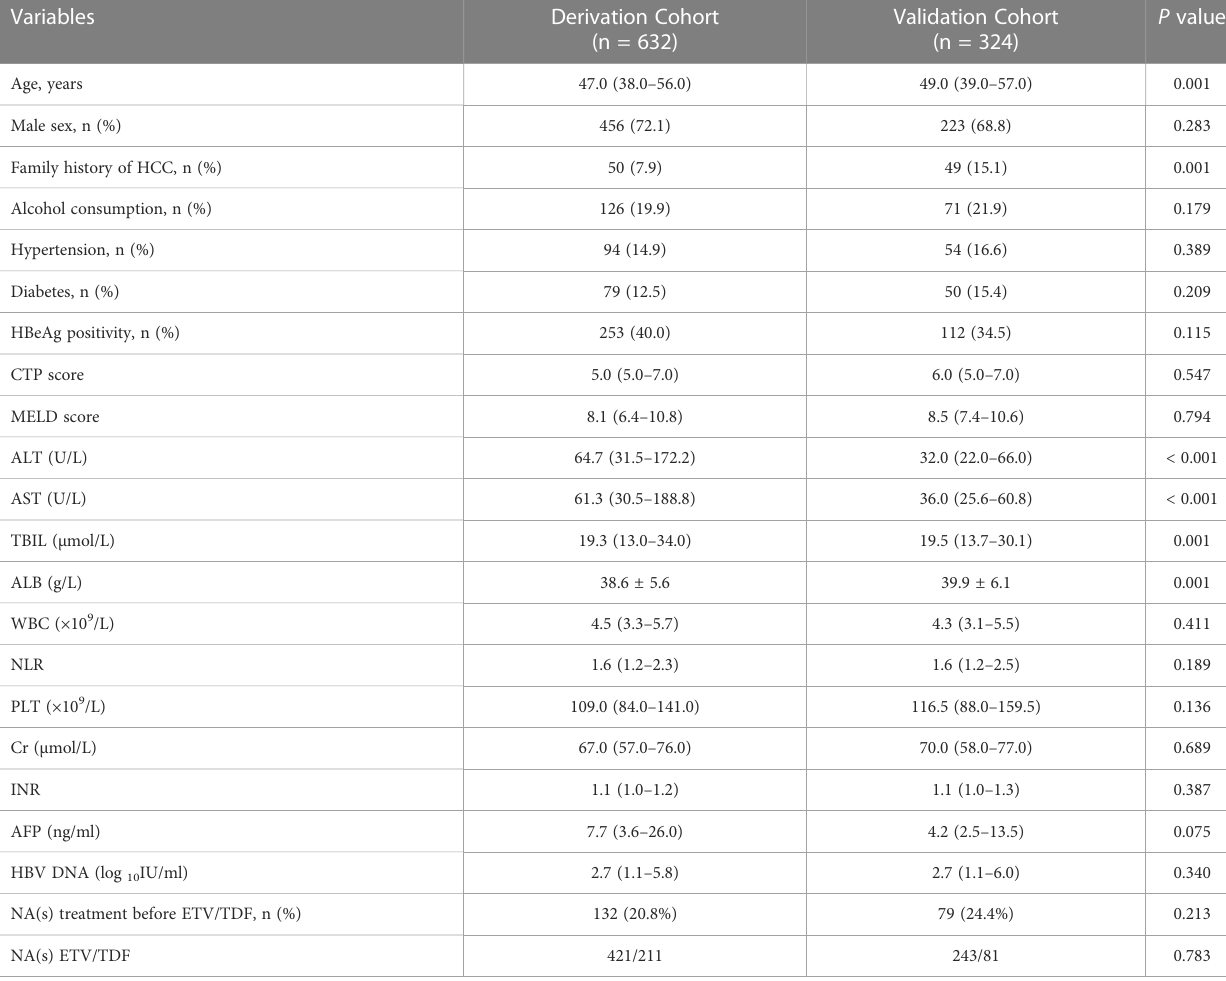
TABLE 1 Characteristics of patients in derivation and validation cohorts at